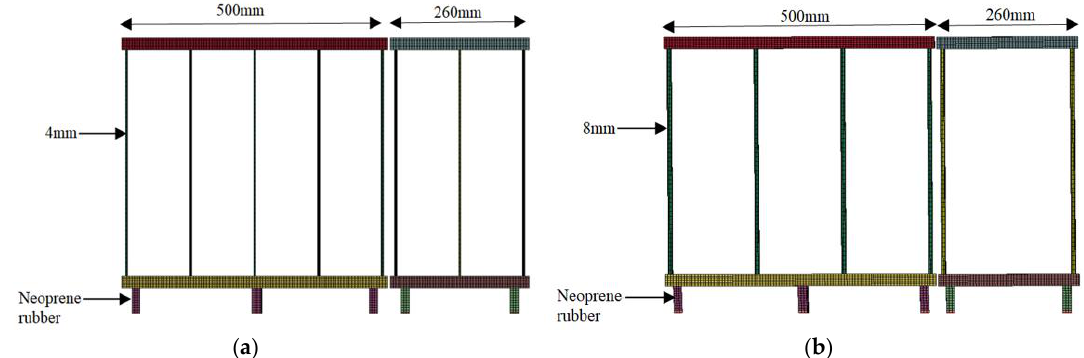
Figure 13. FEM models. ( a ) Flexible BI adjacent models; ( b ) stiffer BI adjacent models. Table 13. Comparison between numerical and experimental responses of adjacent BI models.